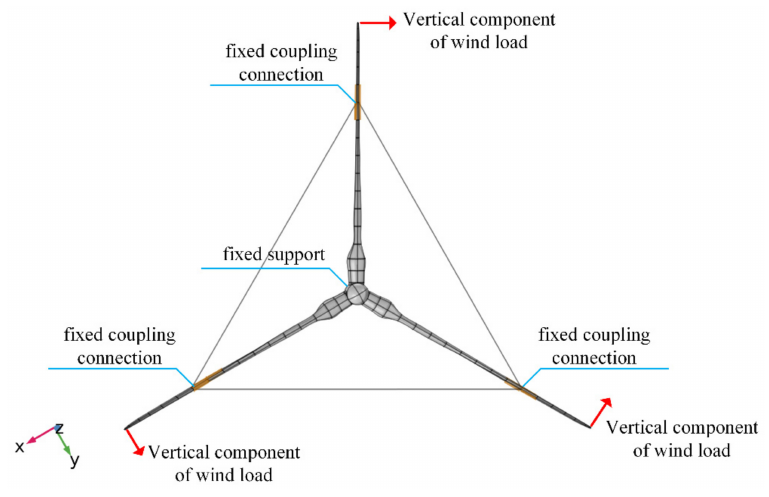
Figure 8. Boundary conditions of the wind turbine